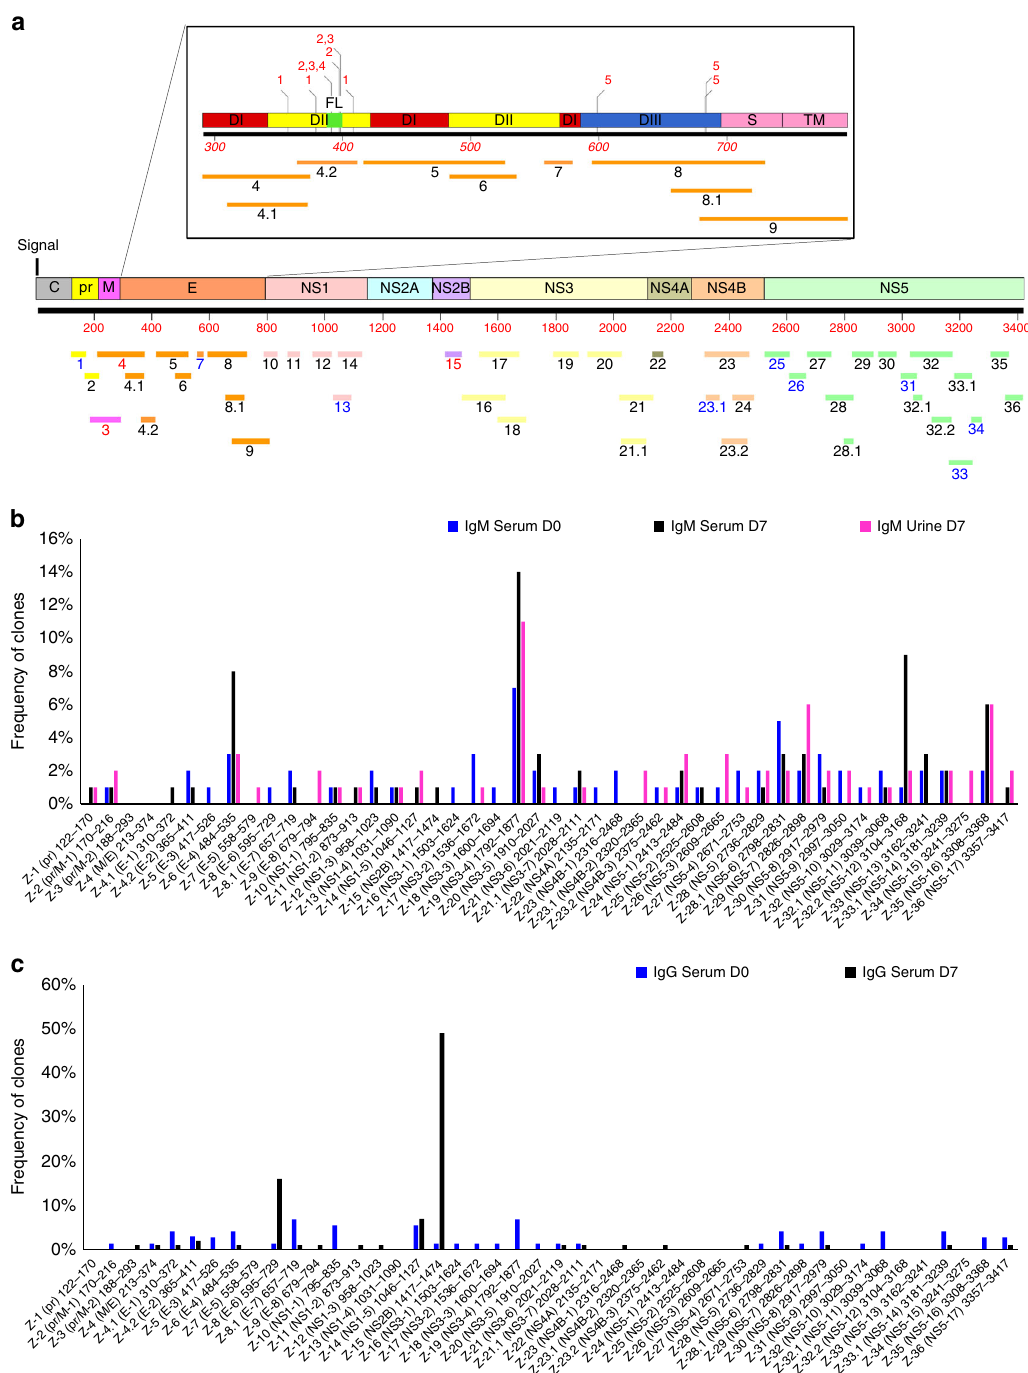
Fig. 2 Frequency of Zika virus (ZIKV) epitopes in serum and urine following Zika virus infection. a Antigenic sites within the ZIKV proteins recognized by serum (days 0, 7) and urine (day 7) IgM and IgG antibodies following Zika virus infection (based on data presented in Fig. 1). The amino-acid designation is based on the ZIKV polyprotein sequence encoded by the complete ZIKV genome (Supplementary Fig. 1). The amino-acid designations on the ZIKV polyprotein (Supplementary Fig. 1) are as follows: C capsid, pr peptide pr, M membrane, E envelope protein, NS non-structural protein. Inset shows expanded version of E protein schematic with domains (D) I, II, and III and fusion loop (FL) shown along with their antigenic sites. Previously described epitopes using MAbs are shown above the ZIKV-E schematic. Critical residues for binding of MAbs, 1, ZIKV-117; 2, 2A10G6; 3, ZIKV-12; 4, ZIKV-15; and 5, ZIKV-116 are depicted. b , c Distribution and frequency of phage clones expressing each of the key ZIKV antigenic sites recognized by IgM ( b ) and IgG ( c ) antibodies in post-ZIKV infection serum (day 0 and day 7) and urine (day 7) are shown. The number of phage clones that expressed each antigenic site was divided by the total number of ZIKV-GFPDL selected clones for each pooled sera or urine samples and represented as a percentage. Phage